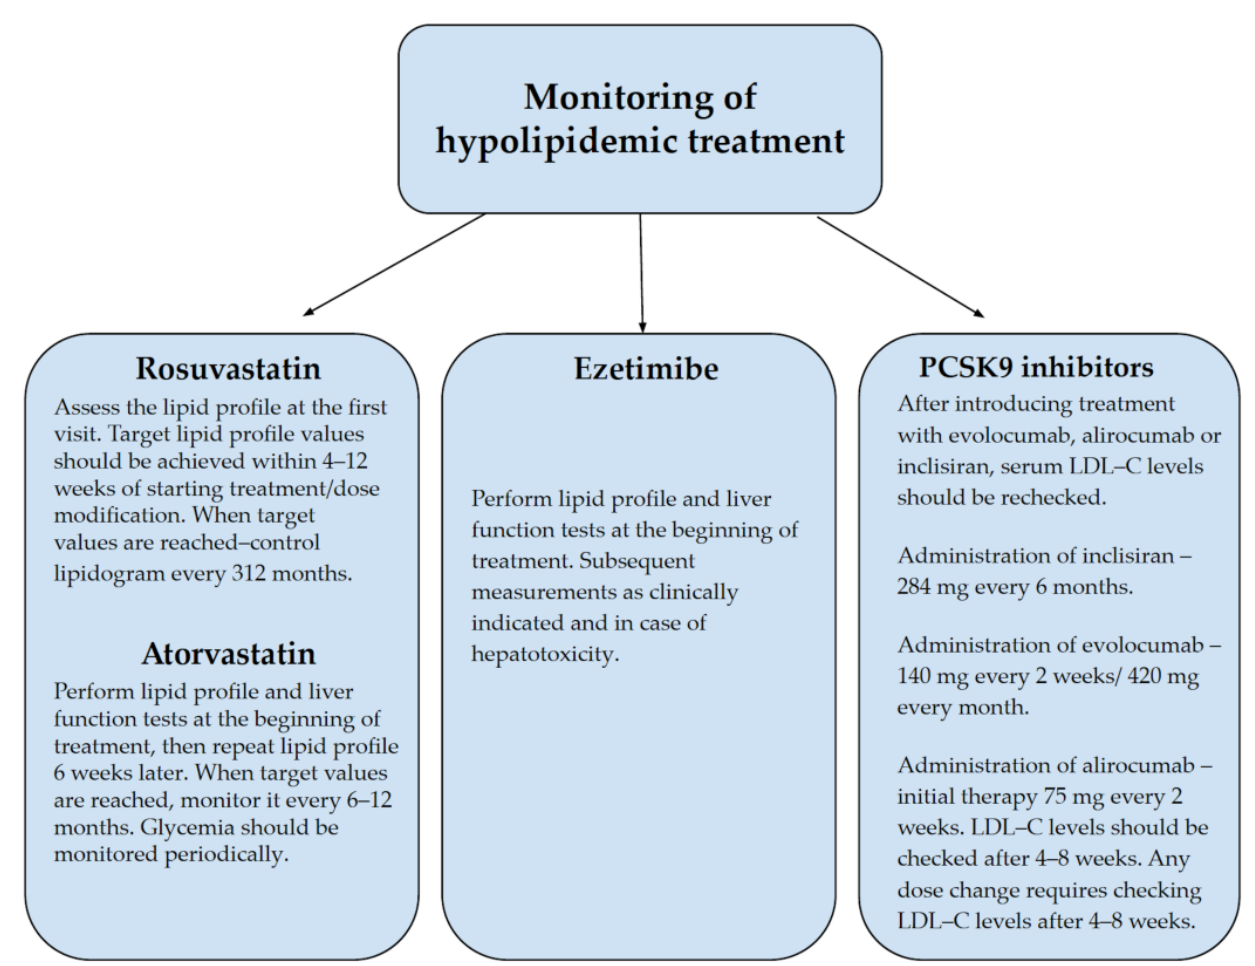
Figure 3. Basic Monitoring Data for Hypolipidemic Treatment [49 – 52].